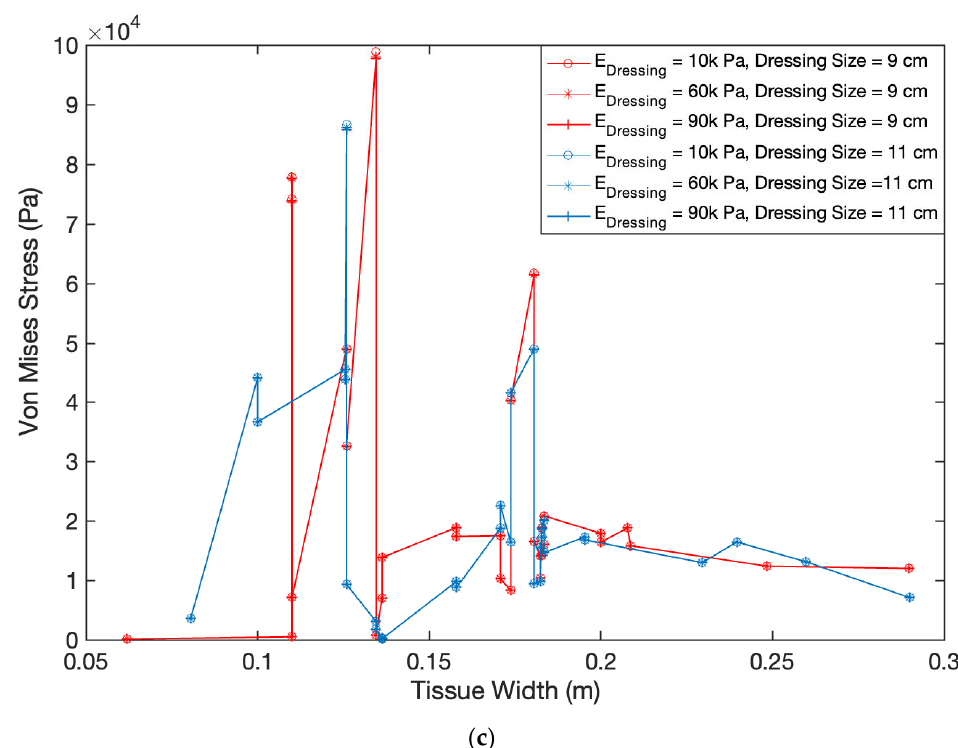
Figure 4. The von Mises stress values in accordance with the location on the tissue surface when dressing length is varied from 9 cm to 11 cm: ( a ) ECM stiffness is controlled at 50 KPa; ( b ) ECM stiffness is controlled at 1 MPa; ( c ) ECM stiffness is controlled at 100